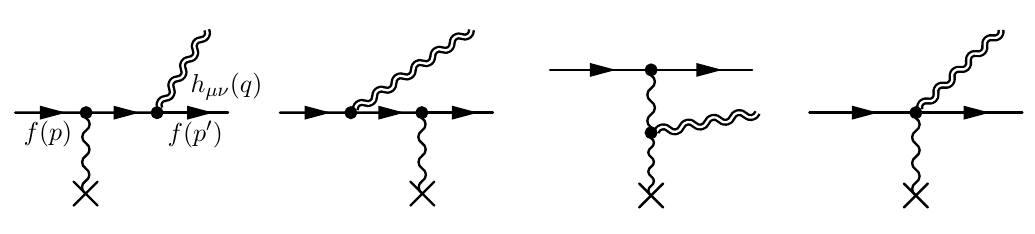
Figure 3 . Electron-positron annihilation.